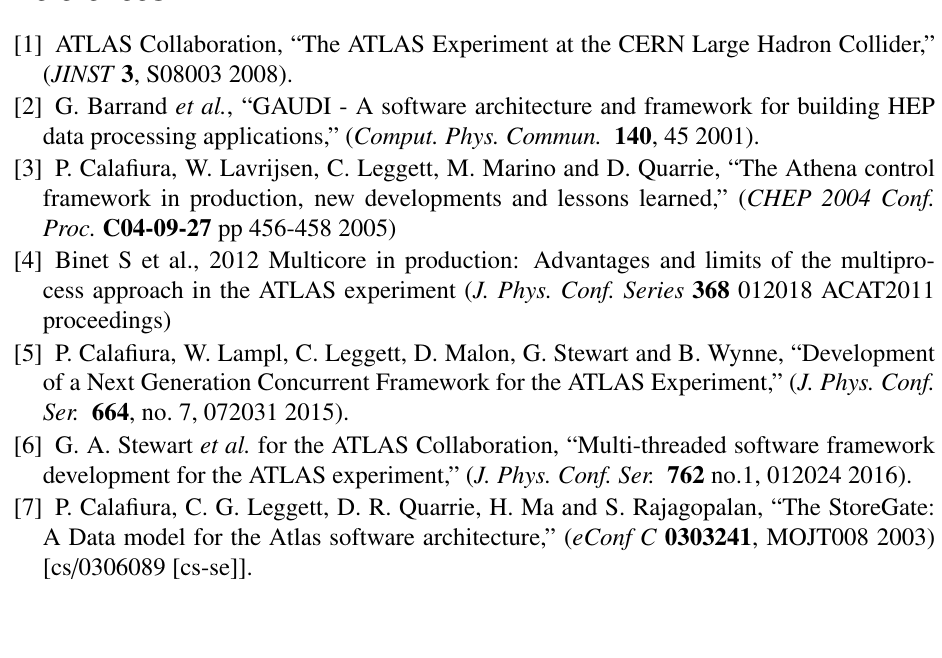
Figure 4. Garbage Collection